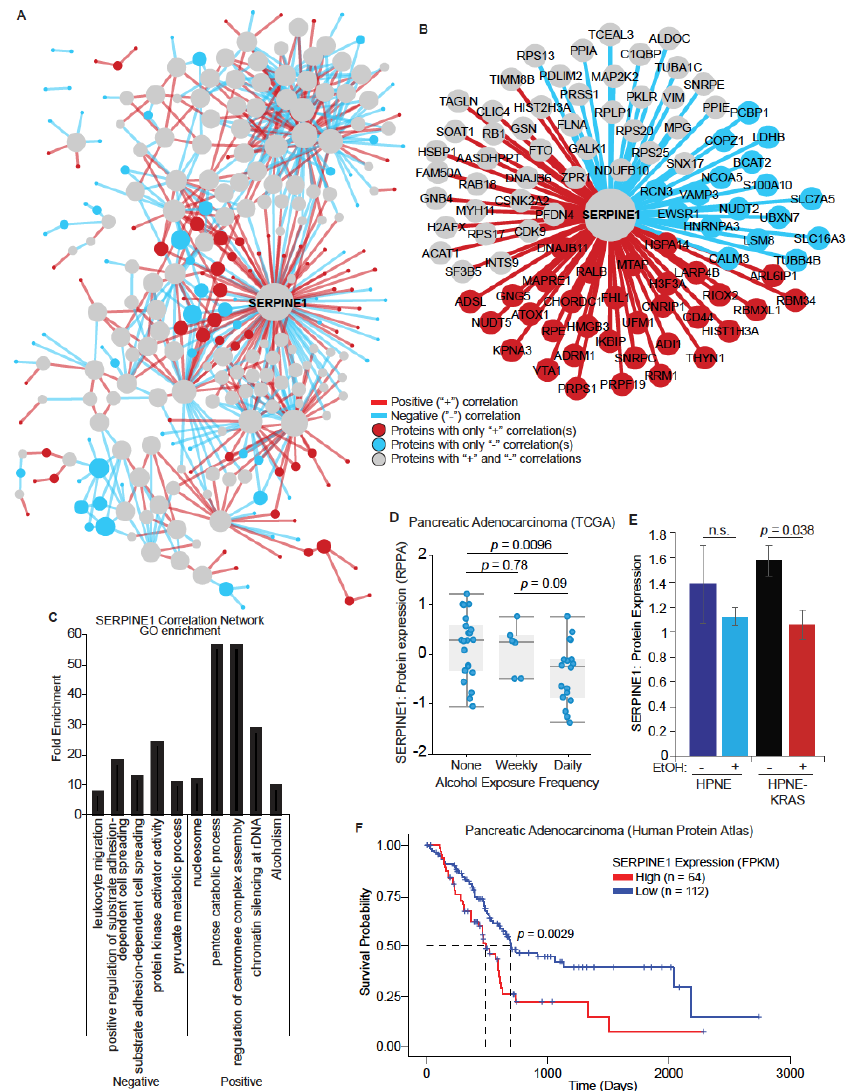
Figure 6. Co-expression network analysis identifies SERPINE1 as a highly interconnected protein involved in alcohol-treated and mutant KRAS HPNE cells. ( A ) Pearson correlation values for each protein–protein pair were determined for HPNE, HPNE EtOH, HPNE-KRAS, and HPNE-KRAS EtOH proteomics expression. Correlations that were ≥ +0.75 in the HPNE-KRAS EtOH and ≤− 0.75 in the HPNE, HPNE EtOH, and HPNE-KRAS were considered positive correlations. Correlations that were ≤− 0.75 in the HPNE-KRAS EtOH and ≥ +0.75 in the HPNE, HPNE EtOH, and HPNE-KRAS were considered negative correlations. Edges represent the presence of a positive (red) or negative (blue) correlation between connected proteins. Nodes represent proteins that have positive correlations (red), negative correlations (blue), or positive and negative correlations (grey) ( n = 3). ( B ) Positive and negative correlations found for SERPINE1 from the overview network ( A ). ( C ) Proteins with positive or negative correlations with SERPINE1 were selected for GO term and KEGG pathway enrichment analysis (analyzed separately). The top four non-redundant terms based on Fisher’s Exact Score for both positively and negatively correlated proteins are represented with the selected term and fold enrichment. ( D ) TCGA protein expression for SERPINE1 in patients with various alcohol exposure. ( E ) SERPINE1 protein expression determined by quantitative proteomics. n.s, not significant. ( F ) Kaplan – Meier survival probability for patients with high (red) or low (blue) SERPINE1 expression.